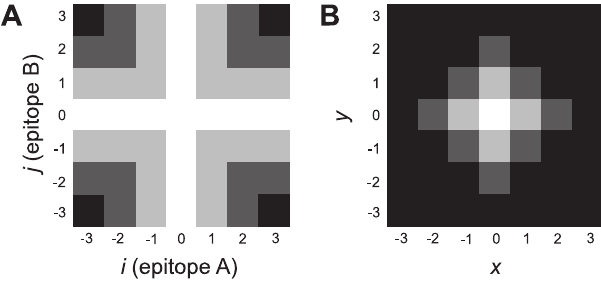
Figure 4. Cross-Immunity Structure Strains to which strain (0,0) confers full, 37%, 2%, or no cross-immunity are shown in white, light gray, dark gray, and black, respectively.